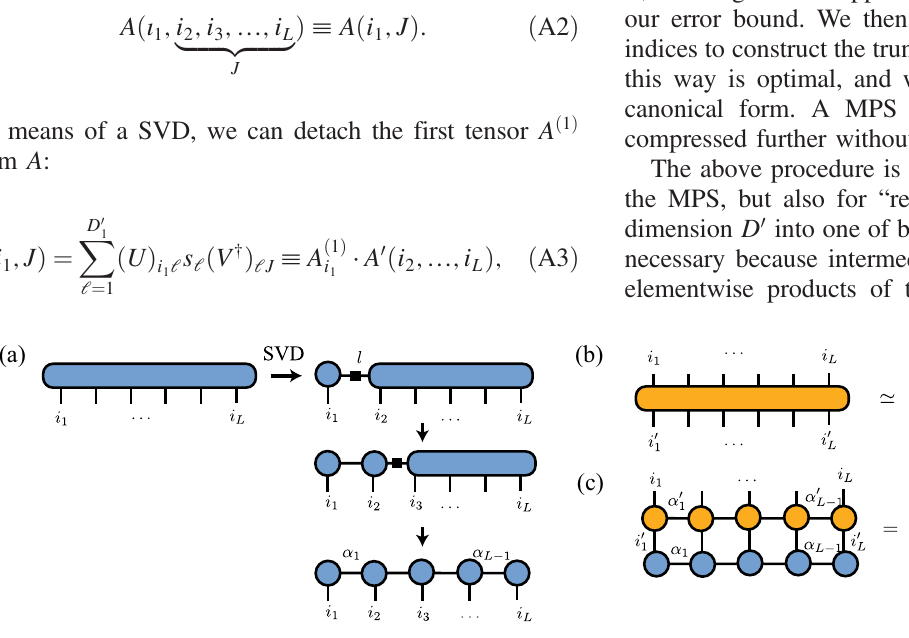
FIG. 26. (a) Decomposing a tensor into a tensor train or matrix product state by SVD, yielding a MPS of the dependence on i . The filled square denotes a diagonal matrix consisting of singular values. The singular values are absorbed into the right singular matrix. (b) MPO. (c) Multiplication of a MPO and a MPS. We do not show the dummy virtual bonds at the edges for